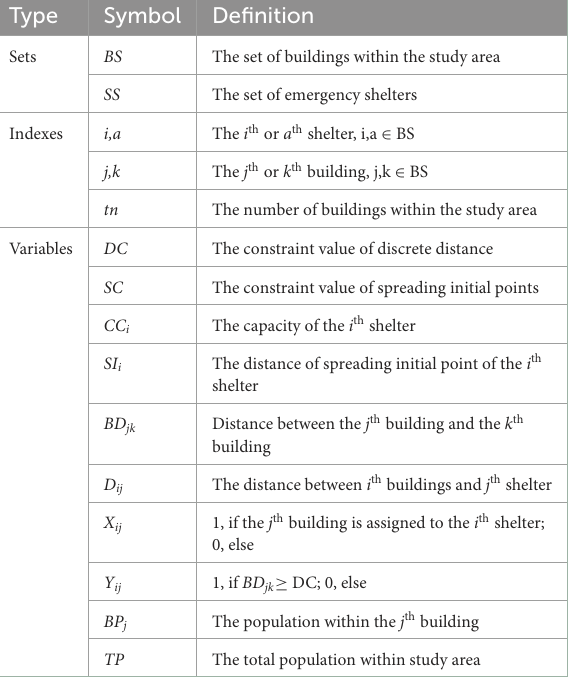
TABLE 1 Definitions for sets, indexes, and variables of the problem.